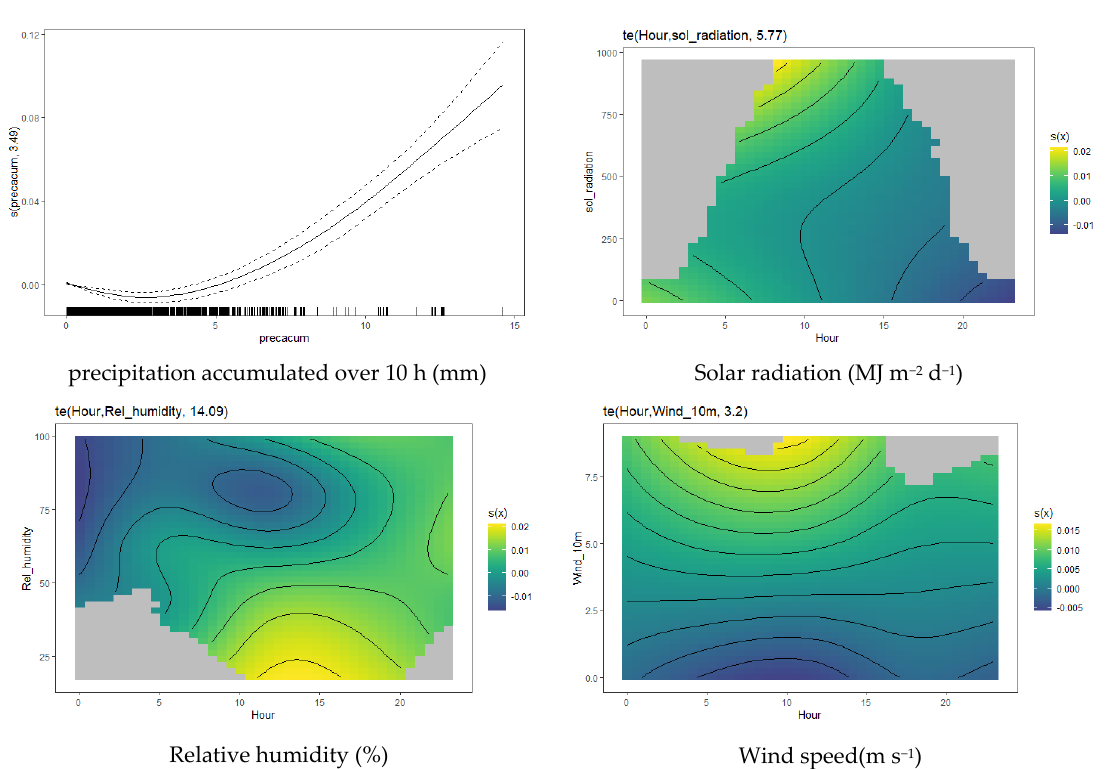
Figure 8. Explanatory variables that explain the difference of evaporation between cobble-stones and concrete slabs surfaces used in GAM (model 4).